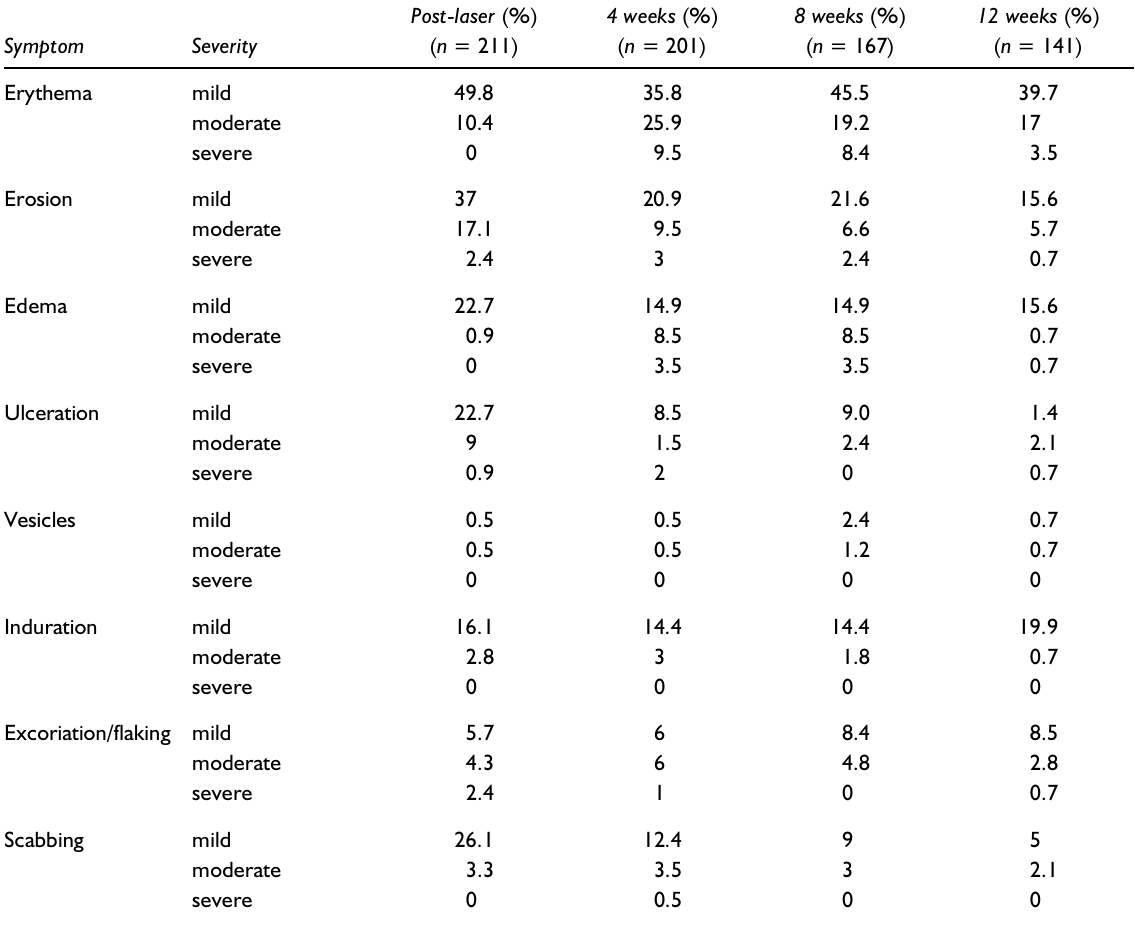
Table 4 Frequency and severity of observed local skin reactions after laser treatment and during treatment with imiquimod 5%